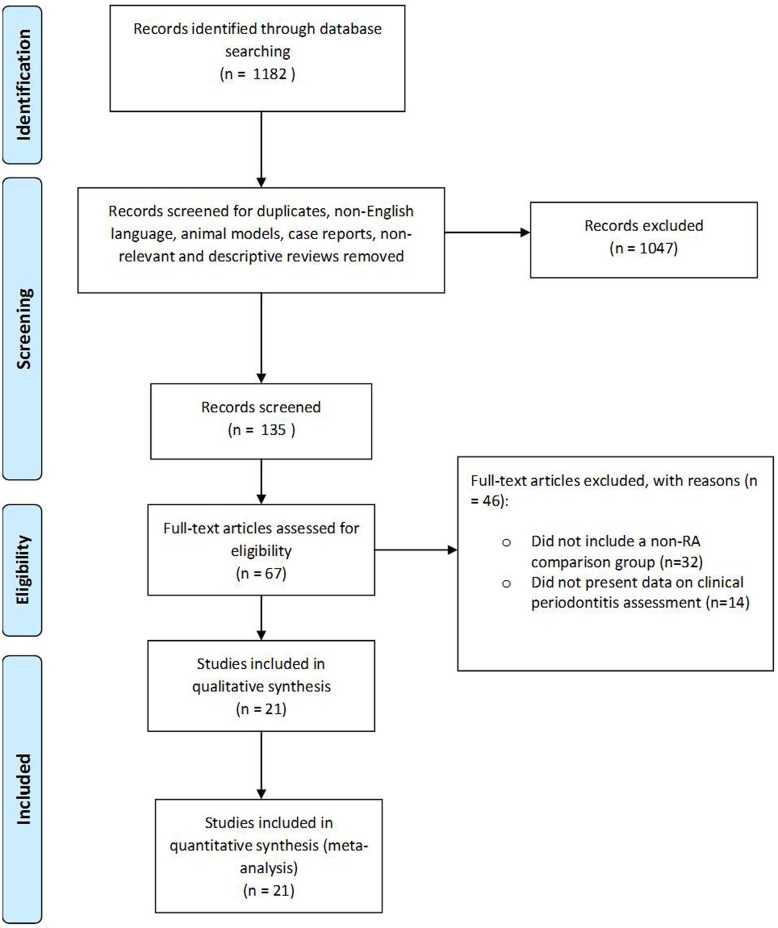
PRISMA flow-chart depicting the results of the search strategy.